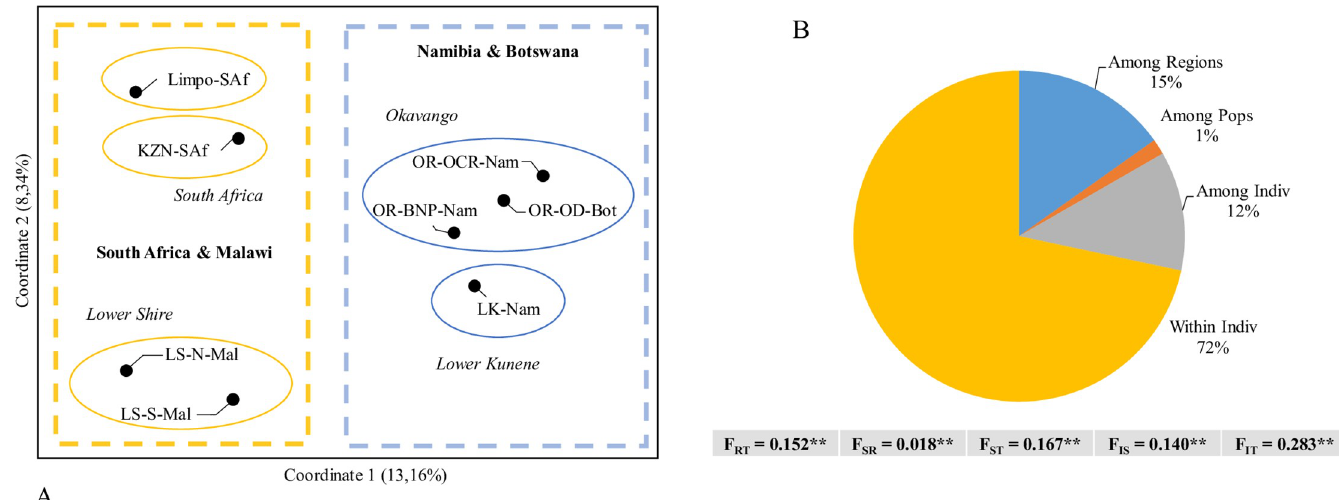
Fig 3. Multivariate analyses of population structure of the Nile crocodile in southern Africa. (A) Principal Coordinate Analysis (PCoA) showing the upper hierarchical population clusters, east and west (primarily differentiated by the first coordinate) as well as the ‘secondary’ population clusters representing each of the regional river systems (Okavango River, Lower Kunene River, Lower Shire River, Limpopo and KwaZulu-Natal regions). [OR-BNP-Nam: Okavango River system— Bwabwata National Park–Namibia, OR-OD-Bot: Okavango River system—Okavango Delta—Botswana, OR-OCR-Nam—Okavango Crocodile Ranch—Okavango River—Namibia, LK-Nam–Lower Kunene River—Namibia, LS-N-Mal–Lower Shire River (North)—Malawi, LS-S-Mal–Lower Shire River (South)—Malawi, and Limpo-SAf–Limpopo River—South Africa, KZN-SAf–KwaZulu-Natal—South Africa.] (B) Molecular Analysis of Variance (AMOVA) showing significant population differentiation between river systems, but also amongst ‘sub-populations’ within river systems, although most of the genetic variation can be ascribed to within individual variation ( �� statistically significant at the 1% nominal level).